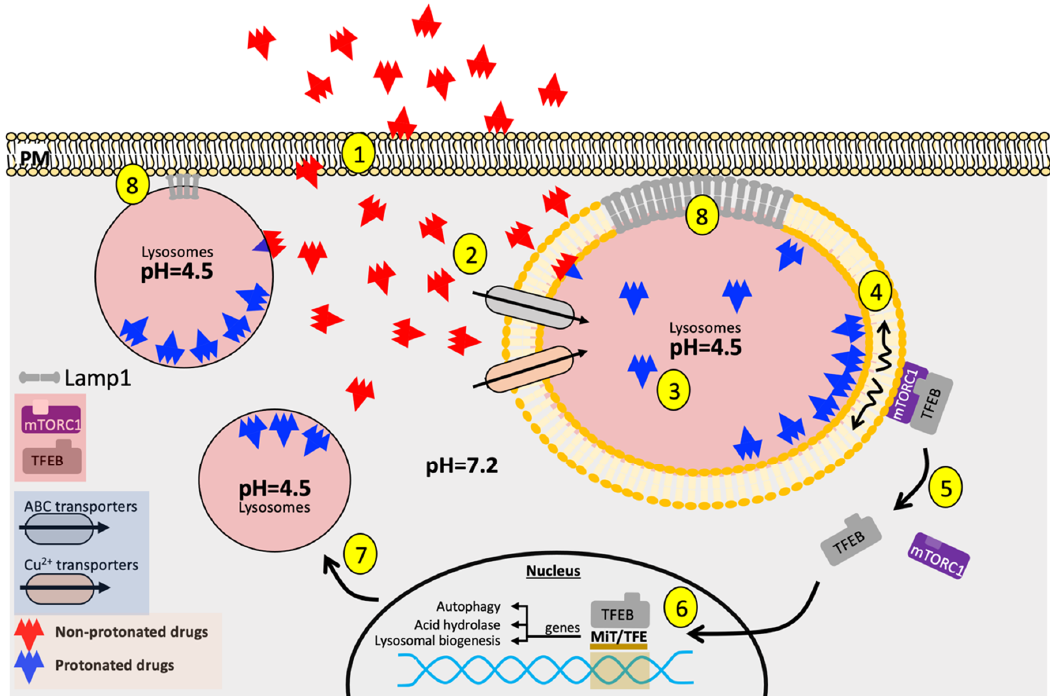
Figure 1. Summary: Lysosomal sequestration of weak-base chemotherapeutic compounds leads to lysosomal biogenesis and enhanced cellular clearance, further potentiating therapeutic